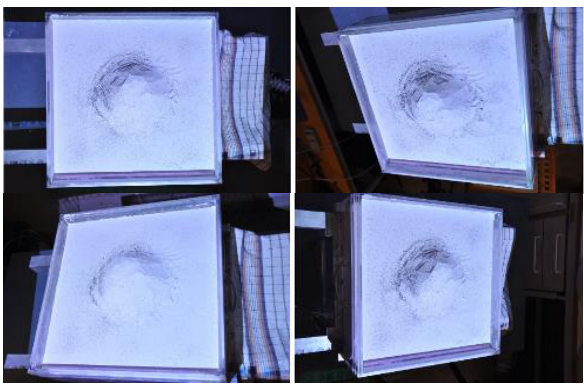
Figure 5. The four images of the Gravillon dataset.